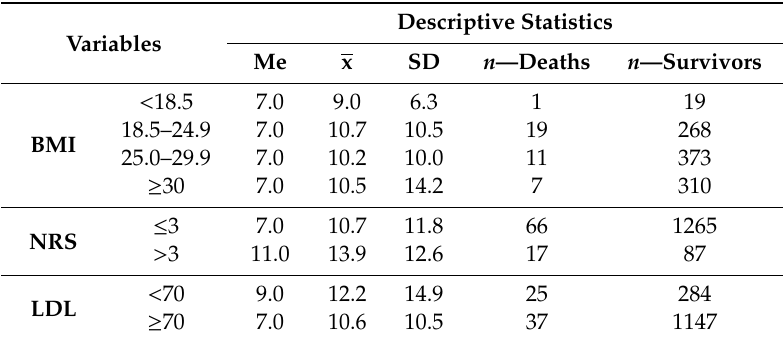
Figure 2. Comparison of survival curves depending on the BMI score. Abbreviations: BMI, body mass index. Table 4. Descriptive statistics for survival time and number of deaths and survival depending on the BMI results, NRS scores and LDL